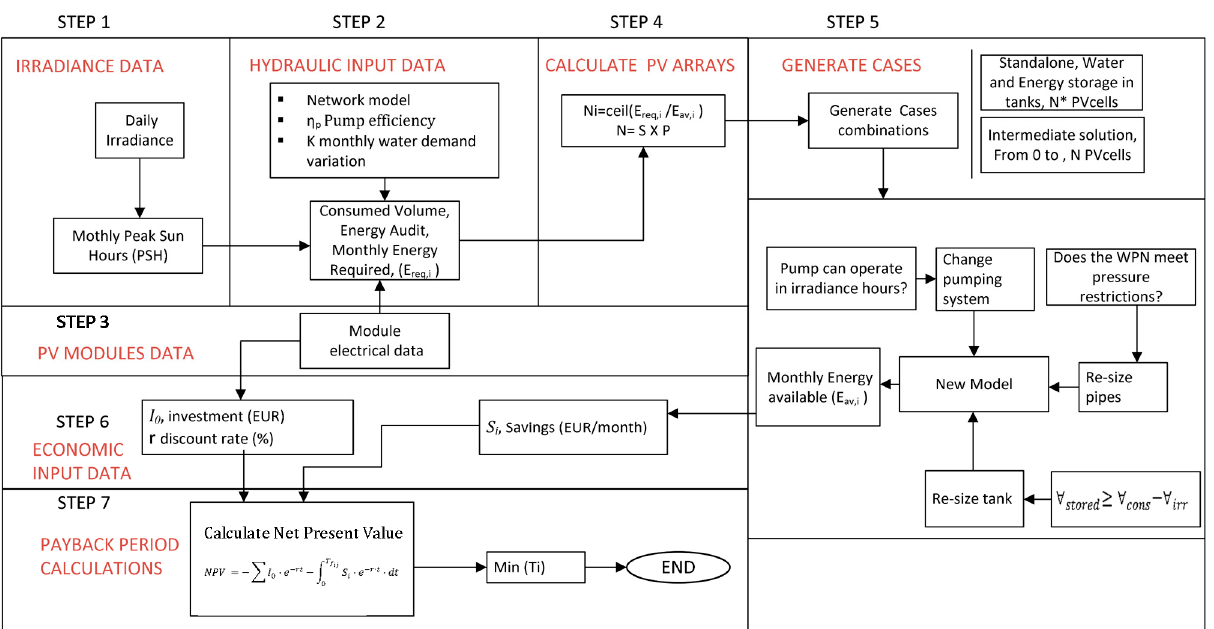
Figure 2. Workflow for the process to calculate the net present value of the alternatives.